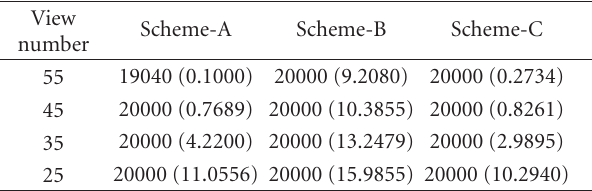
Table 1: Maximum iteration numbers and relative errors associated with each of three representative reconstruction schemes for di ff erent numbers of noise-free projections.